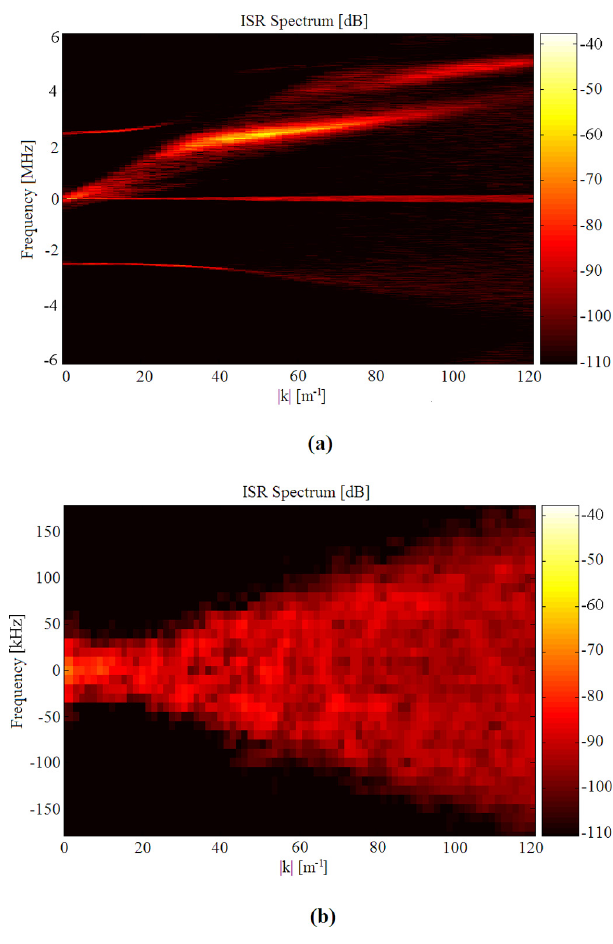
Fig. 12. (a) Incoherent scatter spectrum and (b) close up to the ion acoustic line of the IS spectrum for simulations with n b = 1 . 25 × 10 10 (Sect. 4).